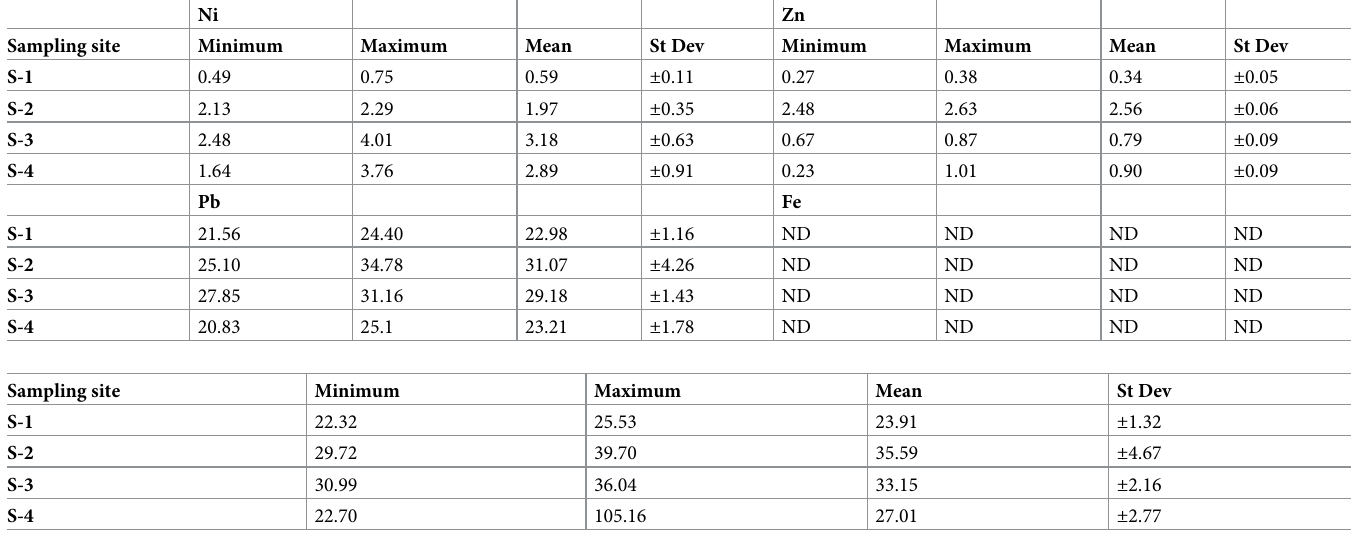
Table 5. (a): Values of individual ecological risk (Ei r ) for heavy metal in Bharalu river. (b): Values of ecological risk index (RI) for heavy metal in Bharalu